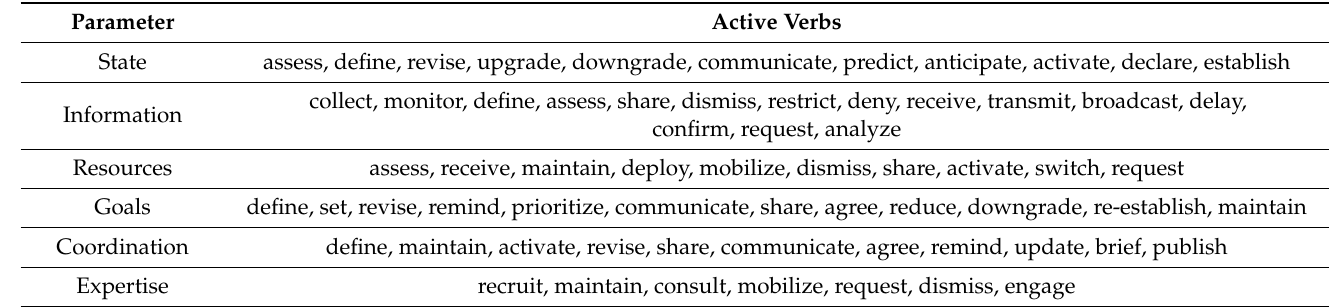
Table 2. Illustration of how example active verbs may be used in connection to the parameters.